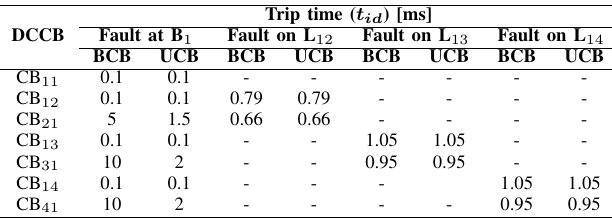
TABLE I T RIP T IMES OF D IFFERENT T YPES OF DC C IRCUIT B REAKERS FOR DC B US AND T RANSMISSION L INE F